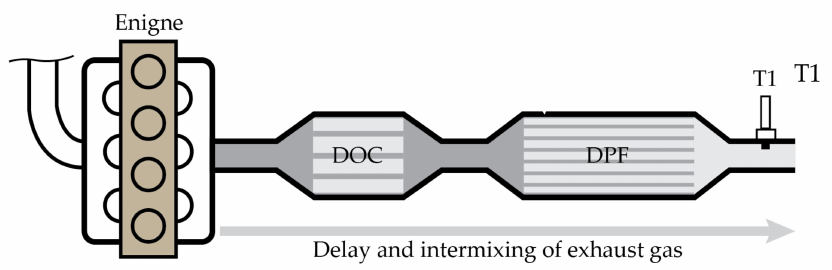
Figure 3. After-treatment layout with retrofit DPF system used in this